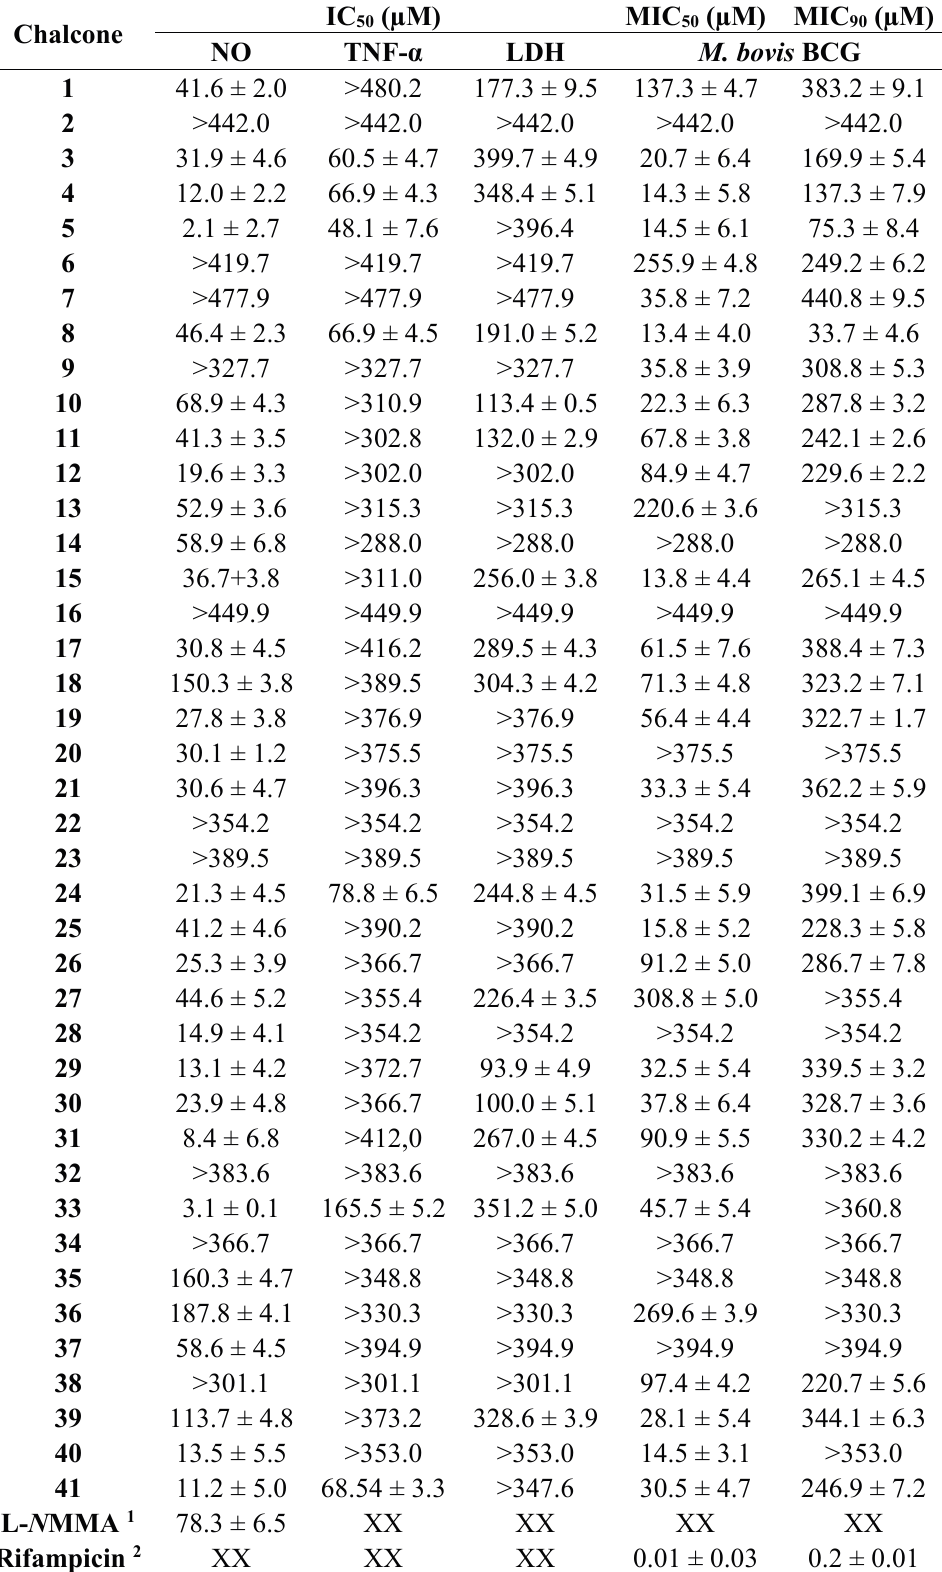
Table 2. Inhibitory effects of chalcones on production of NO and TNF- α by LPS-stimulated RAW 264.7 macrophages, on growth of M. bovis BCG in culture and evaluation of chalcone cytotoxicity by LDH